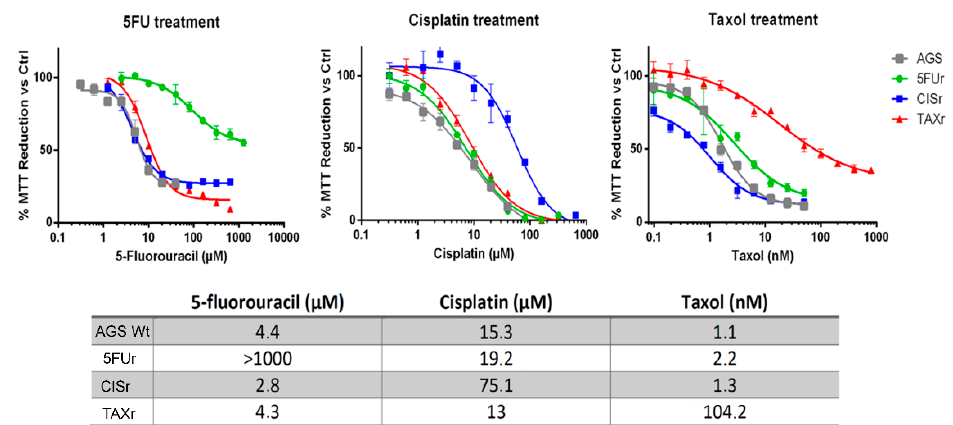
Figure 1. Establishment of AGS-resistant cell lines. AGS cell line chronically subjected to 5-FU, CIS or TAX, called hereafter 5FUr, CISr and TAXr respectively, showed increased IC 50 . Cells were exposed to a range of drug concentrations for 72 h and cell viability was assessed by MTT assay. Results of representative experiments are shown. Data are presented as mean ± SD ( n = 5).